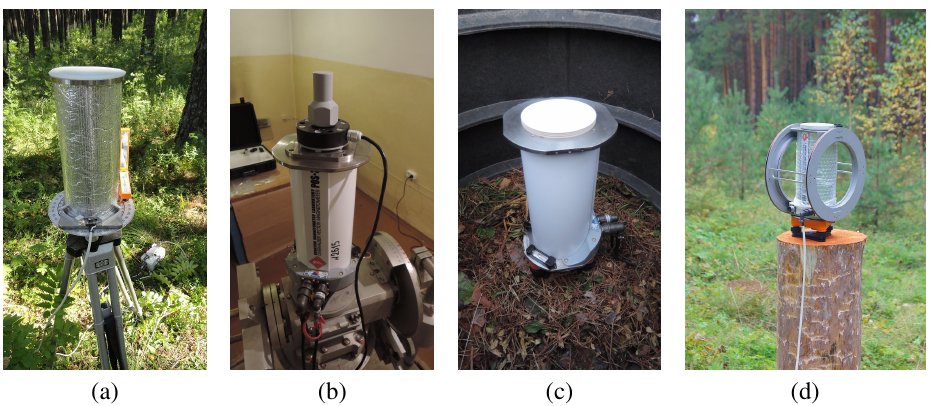
Figure 9. Vector Overhauser magnetometers POS of QMLab at the Observatory Arti: (a) ZT- magnetometer POS-3 No.1 during work on Repeat Station point; (b) component Overhauser magne- tometer POS-3 No.5 with a digital tilt meter on a test stand in a special verification pavilion; (c) POS-3 No.5 outdoors in a protective casing; (d) POS-4 No.3 during the intercomparison of scalar magnetome- ters at the observatory Arti in 2017 [13].